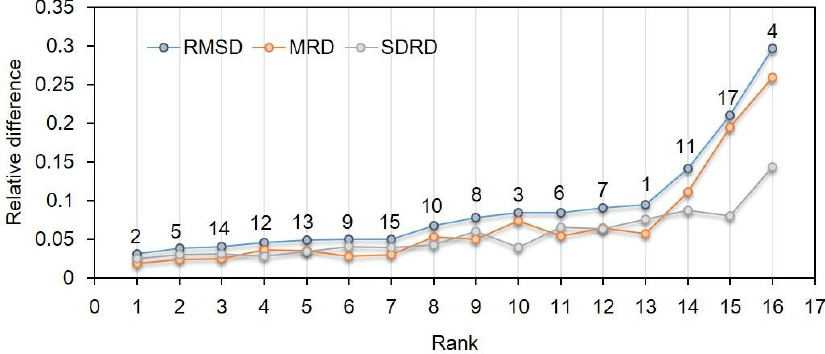
Figure 5. Rank ordered RMSD with its MRD and SDRD for the surface albedo.